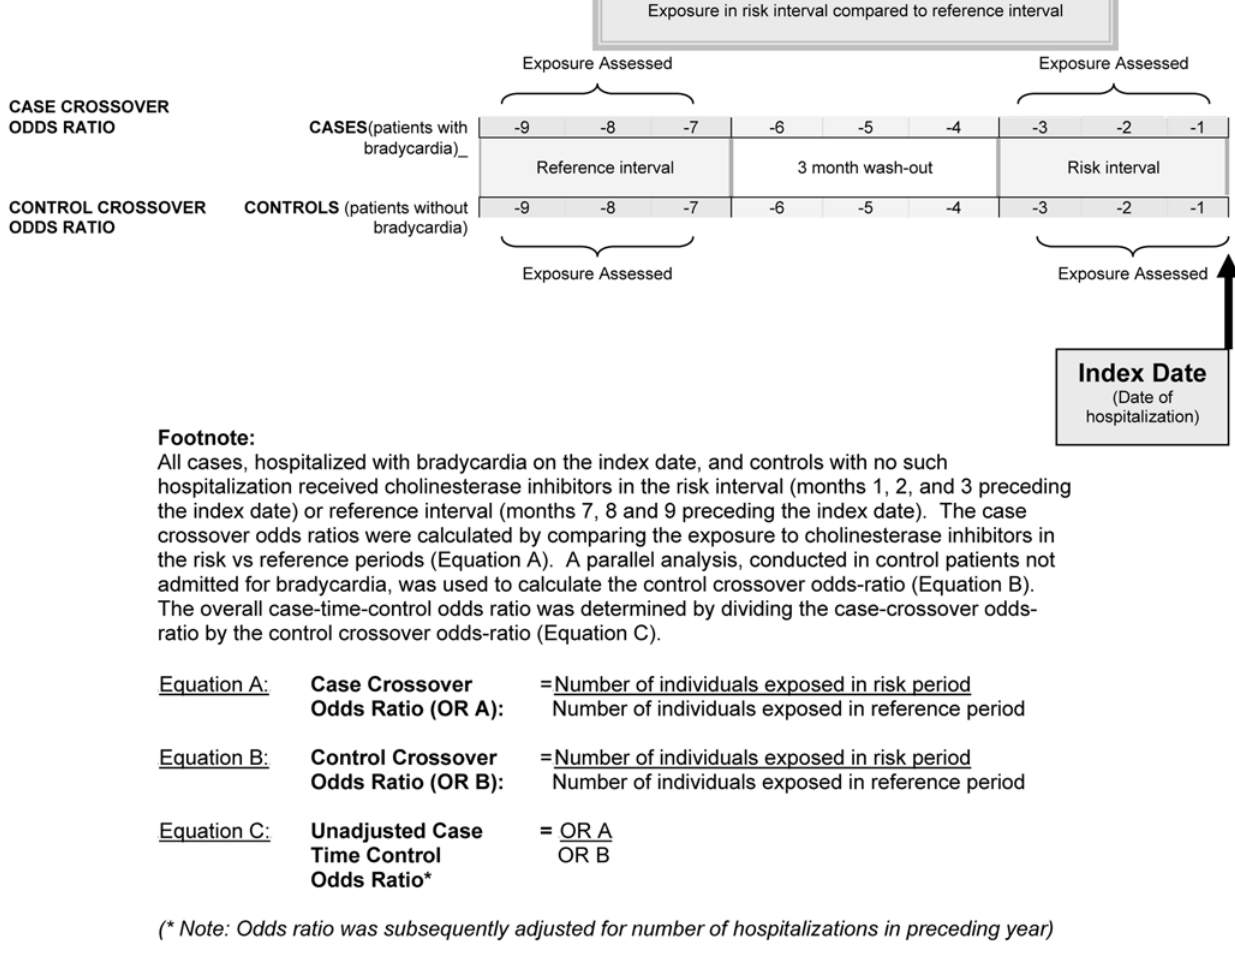
Figure 1. Case-time-control design.